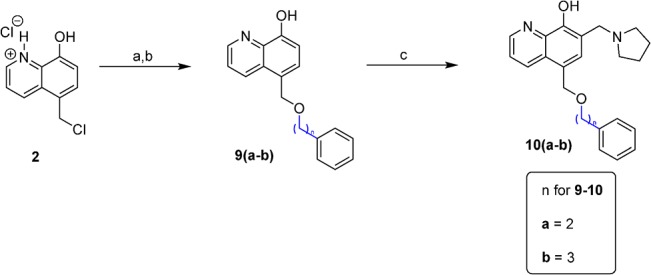
Synthesis of compounds 10a-10b.Reagents and conditions: (a) 2-phenylethanol for 9a, 3-phenyl-1-propanol for 9b, 110 oC; (b) NH4OH, H2O, Et2O, pH 8–10; (c) paraformaldehyde, pyrrolidine, EtOH, reflux.